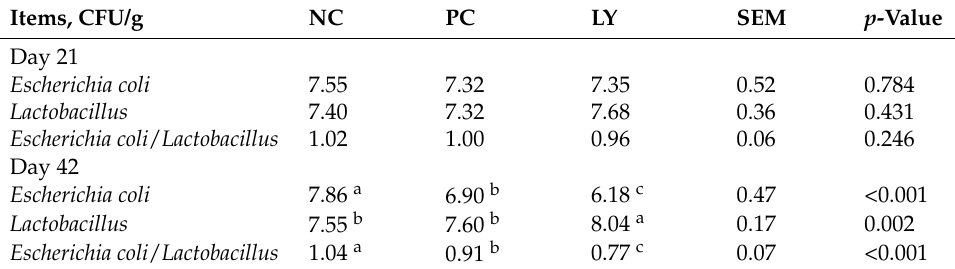
Table 9. Effect of dietary treatments on the cecum microbiota of broilers.